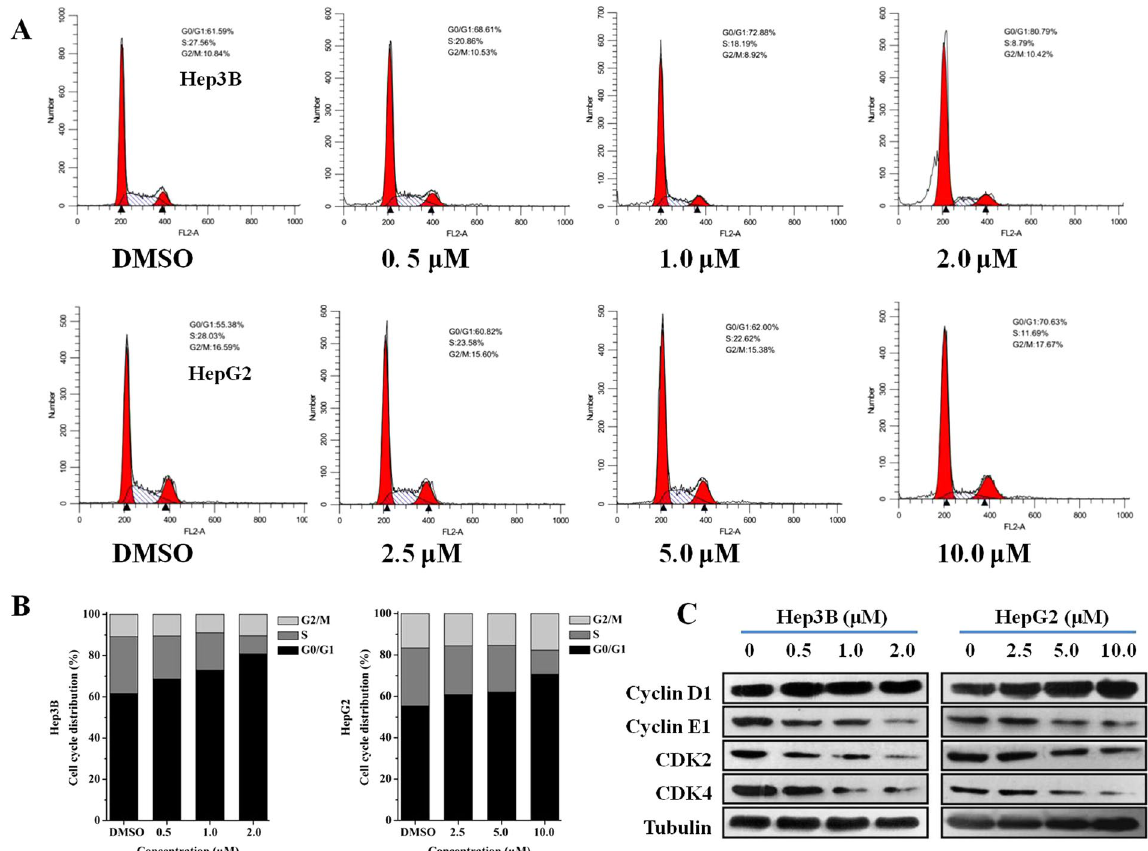
Figure 3. Cell cycle effects of daphnegiravone D on Hep3B and HepG2 cells. ( A ) Cells were induced with a variety of concentration (0.5–2.0 μ M for Hep3B and 2.5–10.0 μ M for HepG2 cells) respectively for 48 h, and cell cycle was analyzed by flow cytometry. ( B ) The histograms were presented to describe the effect of cell cycle. ( C ) Effects of daphnegiravone D on the expression of G0/G1-related proteins including cycline D1, cycline E1, CDK2, CDK4 were detected in both hepatoma cells. Tubulin was used as a loading